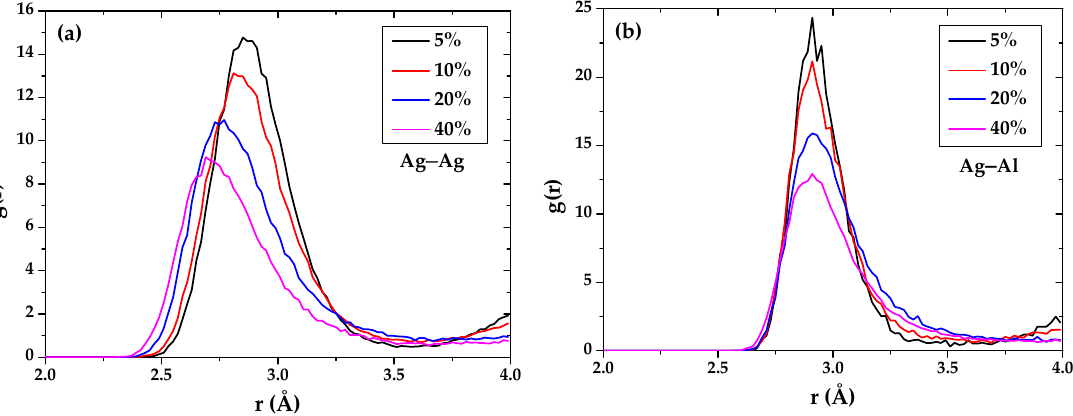
Figure 6. The radial distribution function of ( a ) Ag–Ag and ( b ) Ag–Al in Al-doped silver film deposited in different aluminum composition.